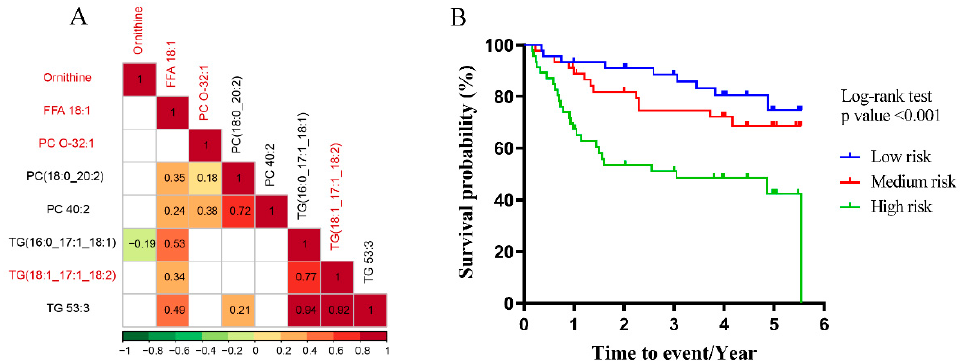
Figure 5. Identification of prognostic panel and the overall survival analysis. ( A ) The correlation matrix of hub nodes. Values and colors represent Pearson correlation coefficients of log-transformed metabolites with significance. The unsignificant correlations ( p > 0.05) are filled with white. The molecules with red font were identified to generate a prognostic panel. ( B ) Kaplan-Meier curve of overall survival according to the panel of hub nodes identified by MEGENA.